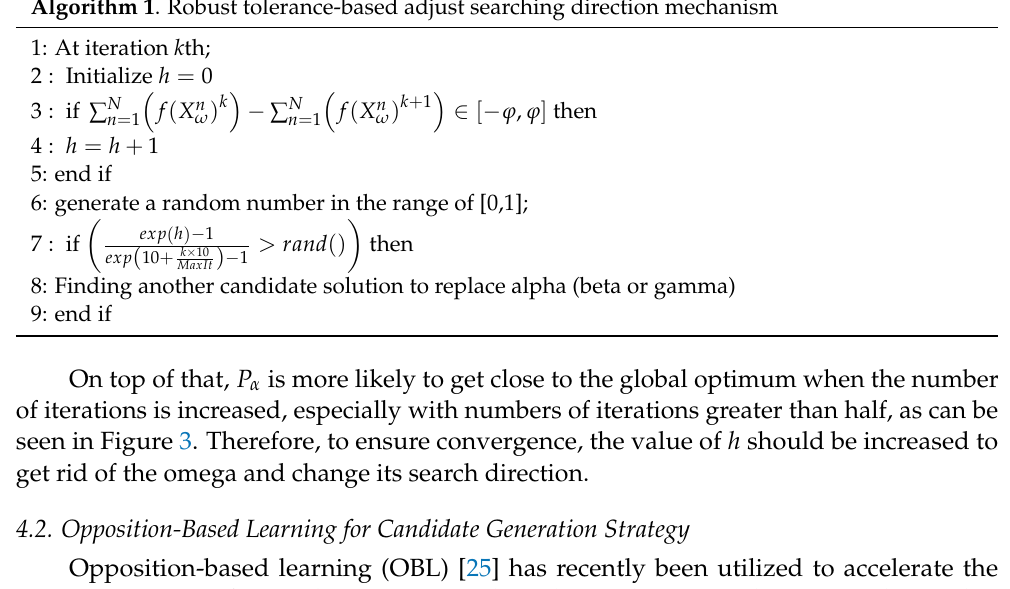
Figure 2. Adjustment probability at different iteration periods. Algorithm 1 . Robust tolerance-based adjust searching direction